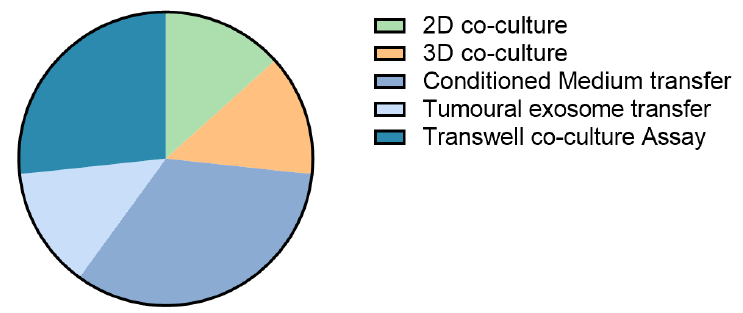
Figure 2. Culture setups to study the effects of tumour cells on CAFs in liver cancer.